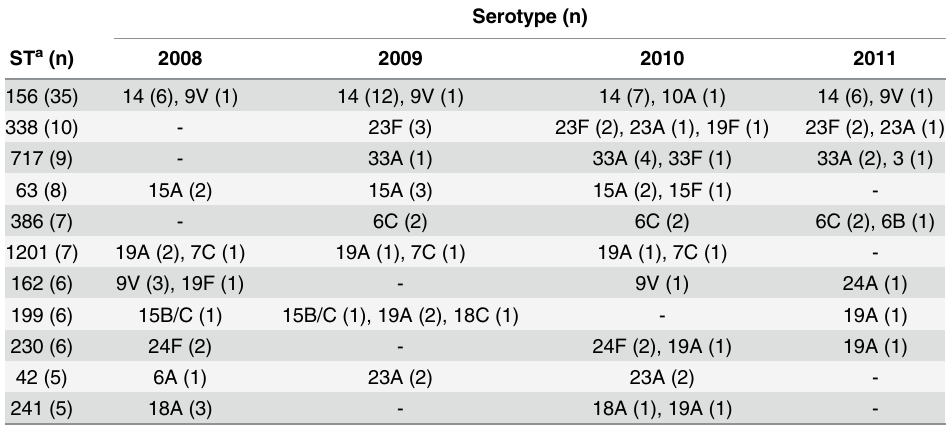
Table 2. Serotype distribution for the STs expressing more than one serotype between 2008 – 2011.